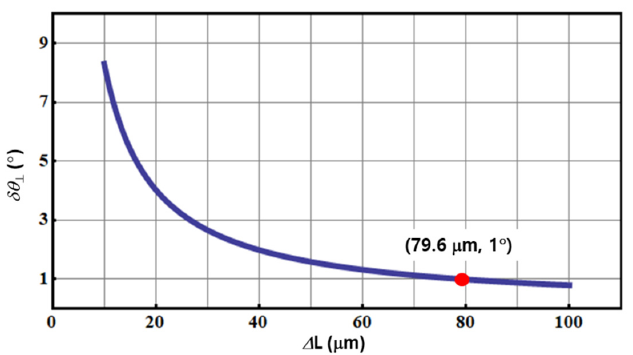
Figure 3. Calculated result of skip angle δ θ ⊥ in the longitudinal direction with variation of the path difference ∆ L in the phase-feeding